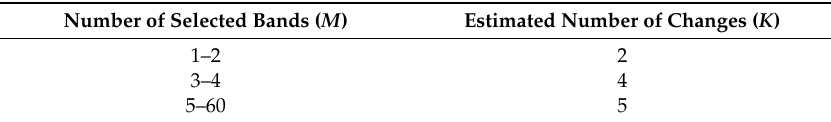
Figure 8. S 2 CVA 2D change representations obtained on X S when: ( a ) M = 2 (two changes are identified); ( b ) M = 5 (five changes are identified). Table 4. Estimated number of changes in multiple CD with different number of selected bands (Yancheng dataset).